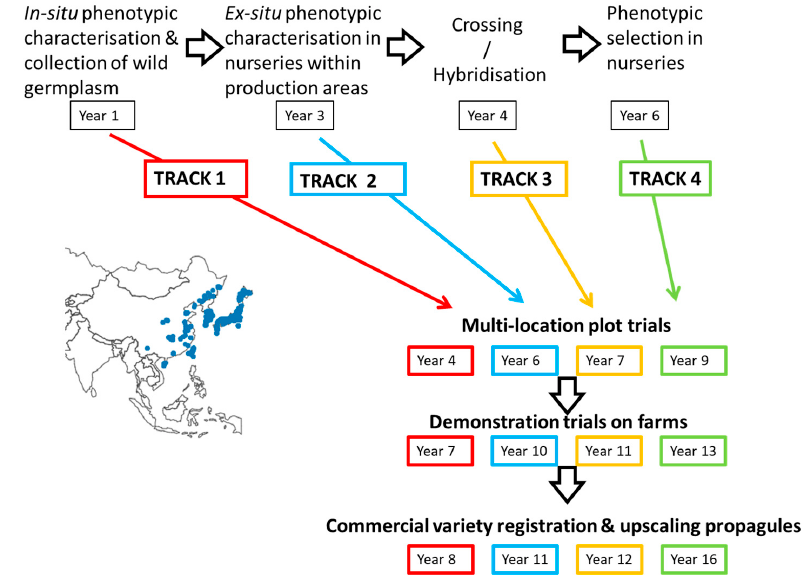
Figure 1. Four interrelated strategic ‘tracks’ for the development of commercial hybrids from wild Miscanthus accessions with estimates of minimum cumulative years needed to take wild germplasm through to the commercial hybrids. Inset, a map showing locations of wild germplasm collections.